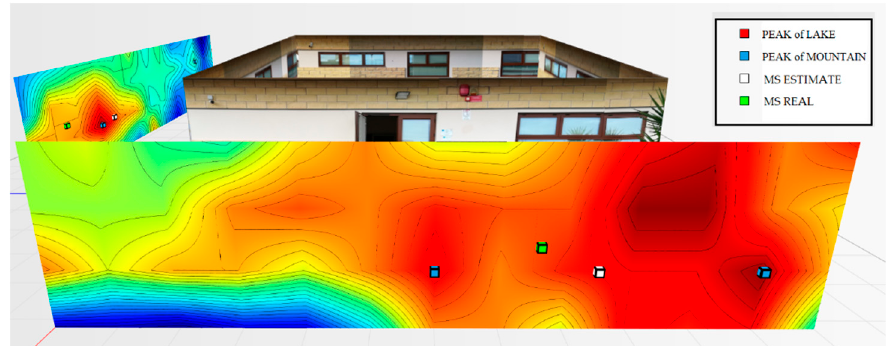
Figure 29. Power level for wall 2 related to the terminal located in the room to the right at 1.4 m.